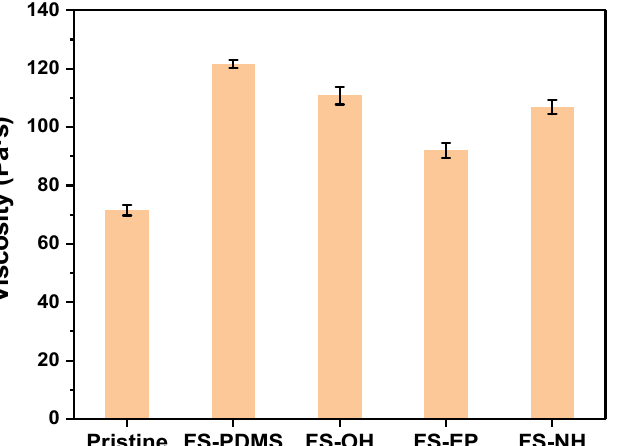
is 0.3 Figure 9. Viscosity of epoxy adhesives with different silica nanoparticles at 23 °C; silica content is 0.3 vol%.